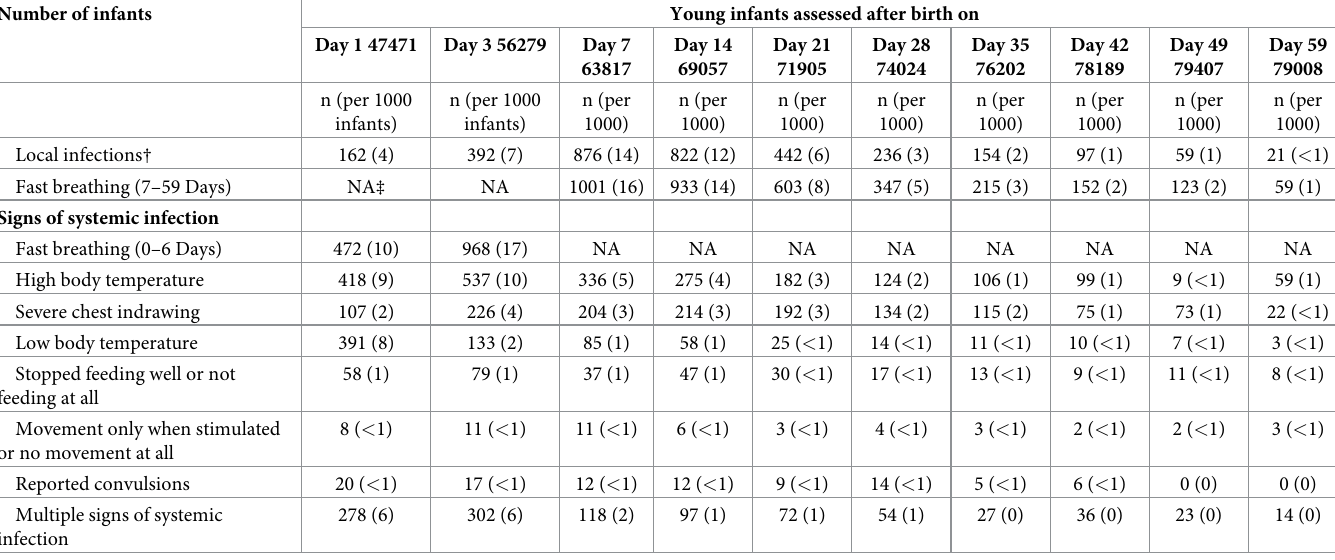
Table 1. Frequency of signs of infection by age of assessment (per 1000 infants) reported by CHWs/CHEWs � . Number of infants Young infants assessed after birth on Day 1